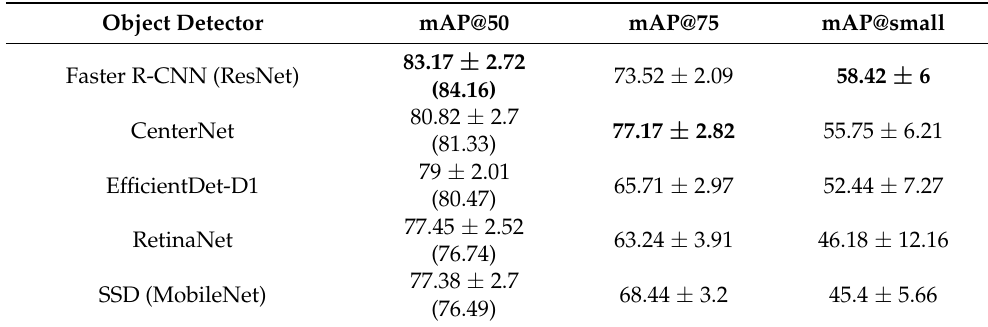
Table 6. The performance of each architecture with only colour augmentation active. In the paren- theses, the training performance is presented for mAP@50. The bold numbers correspond to the best performances.